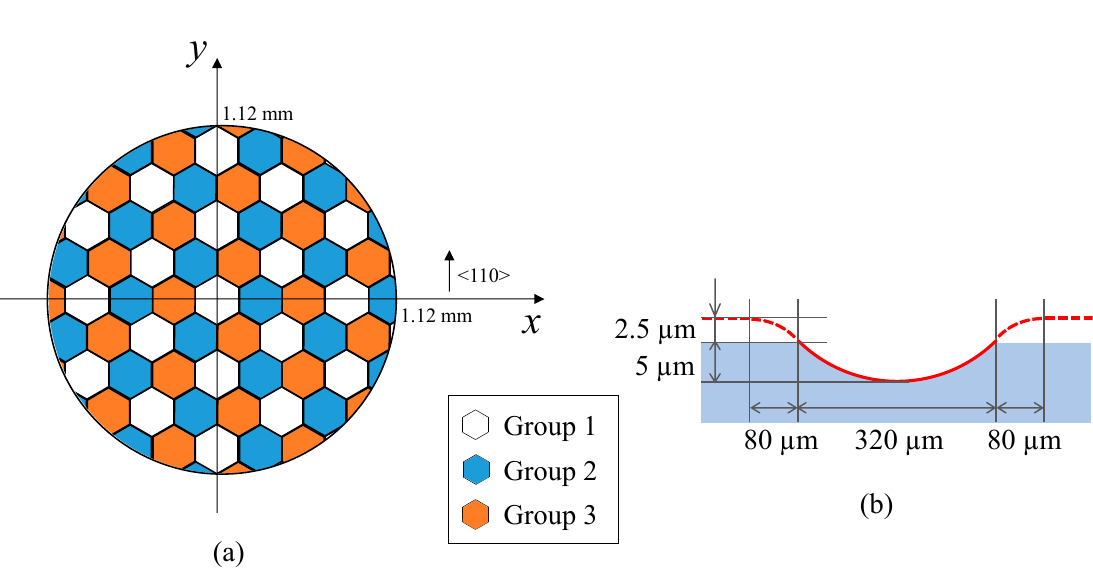
Figure 15. Designed shape of silicon microlens array and tool path for its fabrication: ( a ) schematic of lenslets segment; ( b ) tool path for each lenslet.